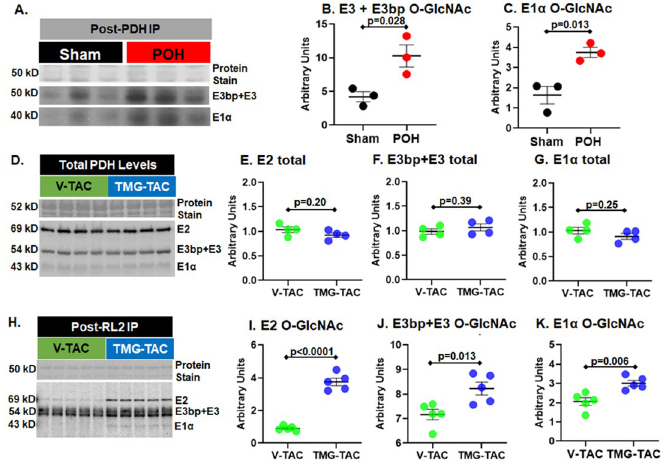
Fig 6. O-GlcNA levels on pyruvate dehydrogenase (PDH) subunits. A-C: O-GlcNAcylation of PDH subunits determined by PDH complex immunocapture followed by western blot with the anti-O-GlcNAc antibody RL2. (A) shows protein staining for the immunocaptured proteins and the RL2 bands at 50 kD and 40 kD. The bands at 50 kD correspond to the subunits E3 and E3 binding partner (E3bp) whereas 40 kD corresponds to the E1 α subunit. (B) Quantification of E3 and E3bp normalized to protein staining. (C) Quantification of the E1 α subunit normalized to protein staining. E2 band was not identified in this immunocapture. D-G: Total PDH protein levels via western blot in V-TAC and TMG-TAC. (D) Protein staining and western blot for PDH subunits. (E) Quantification of the E2 band normalized to protein staining. (F) Quantification of the E3bp+E3 bands normalized to protein staining. (G) Quantification of the E1 α band normalized to protein staining. H-K: O-GlcNAcylation of the PDH subunits determined by O-GlcNAc immunoprecipitation (IP) with the RL2 antibody followed by western blot for PDH subunits. (H) Protein staining after IP with the RL2 antibody along with the post-IP western blot for the PDH subunits. (I) Quantification of the E2 band. (J) Quantification of the E3bp+E3 bands. (K) Quantification of the E1 α band. Bars indicate mean ± standard error of the mean. N = 3 per group for A-C, n = 4 per group for D-G, and n = 5 per group for H-K.